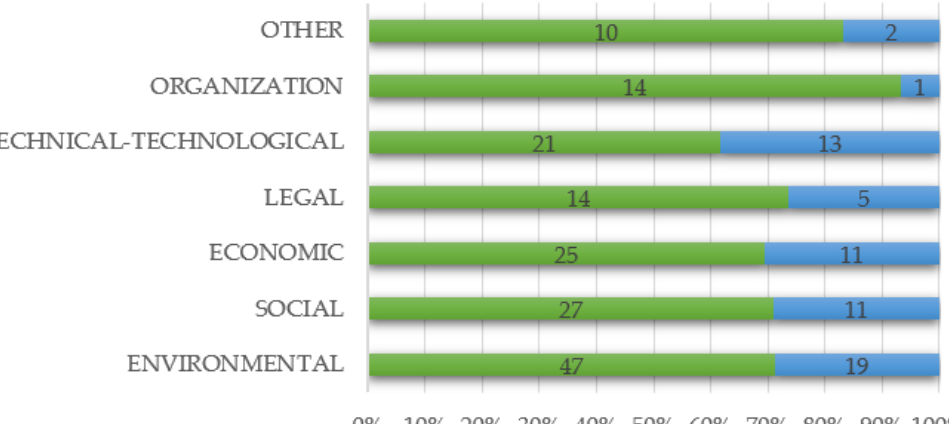
Figure 4. Relation of the total number of filtered publications and research area group in the period 2012–2022.